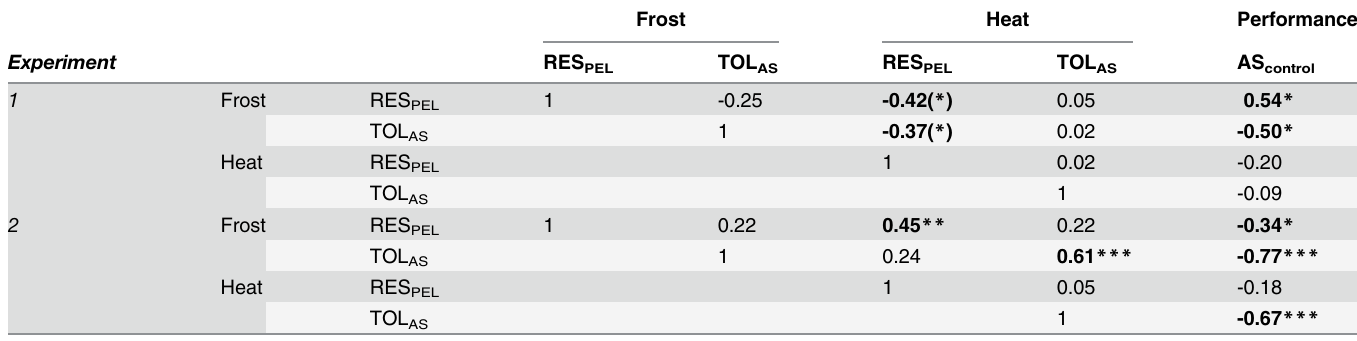
Table 3. Correlations between frost/heat resistance (RES PEL ), frost/heat tolerance based on asymptotic size (TOL AS ), and performance based on asymptotic rosette size of control plants of Arabidopsis lyrata (AS control ) for two